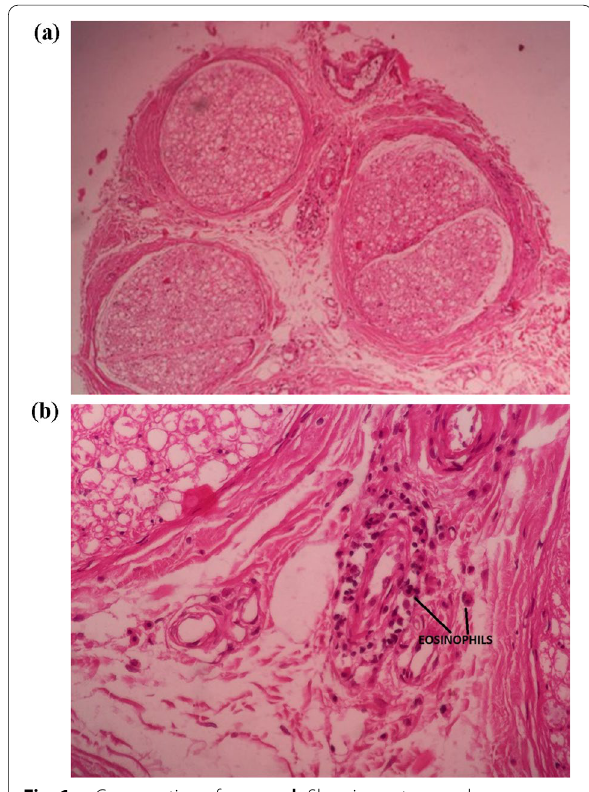
Fig. 1 a Cross section of a nerve. b Showing extravascular